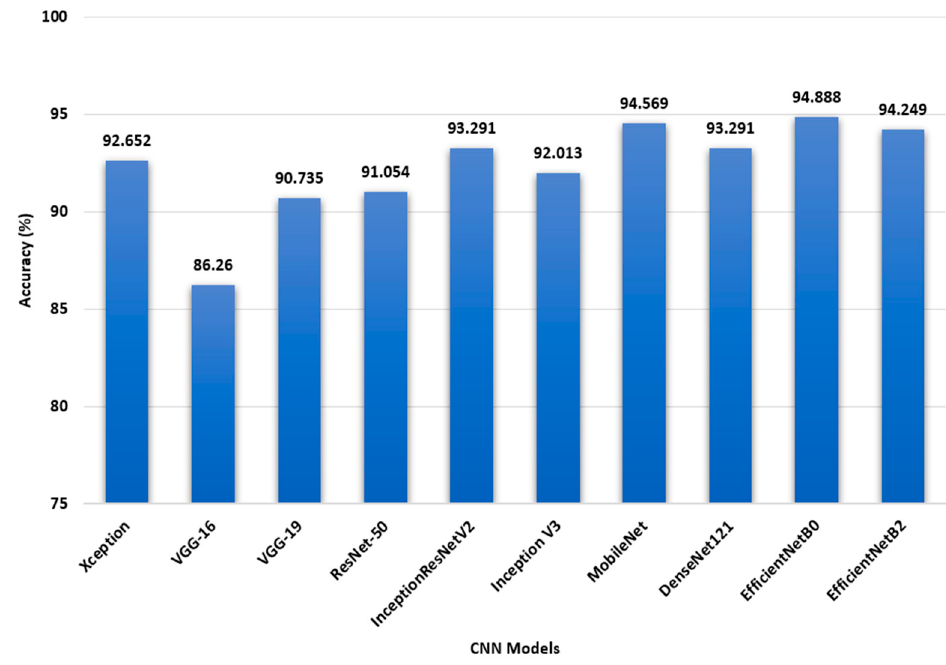
Figure 4. Performance of eight CNN model on the ship classification test set.